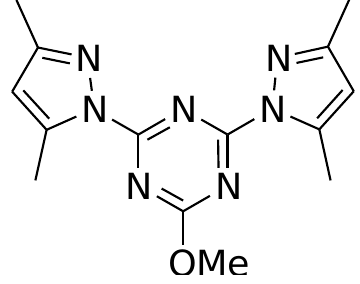
Figure 1. Structure of the ligand ( L